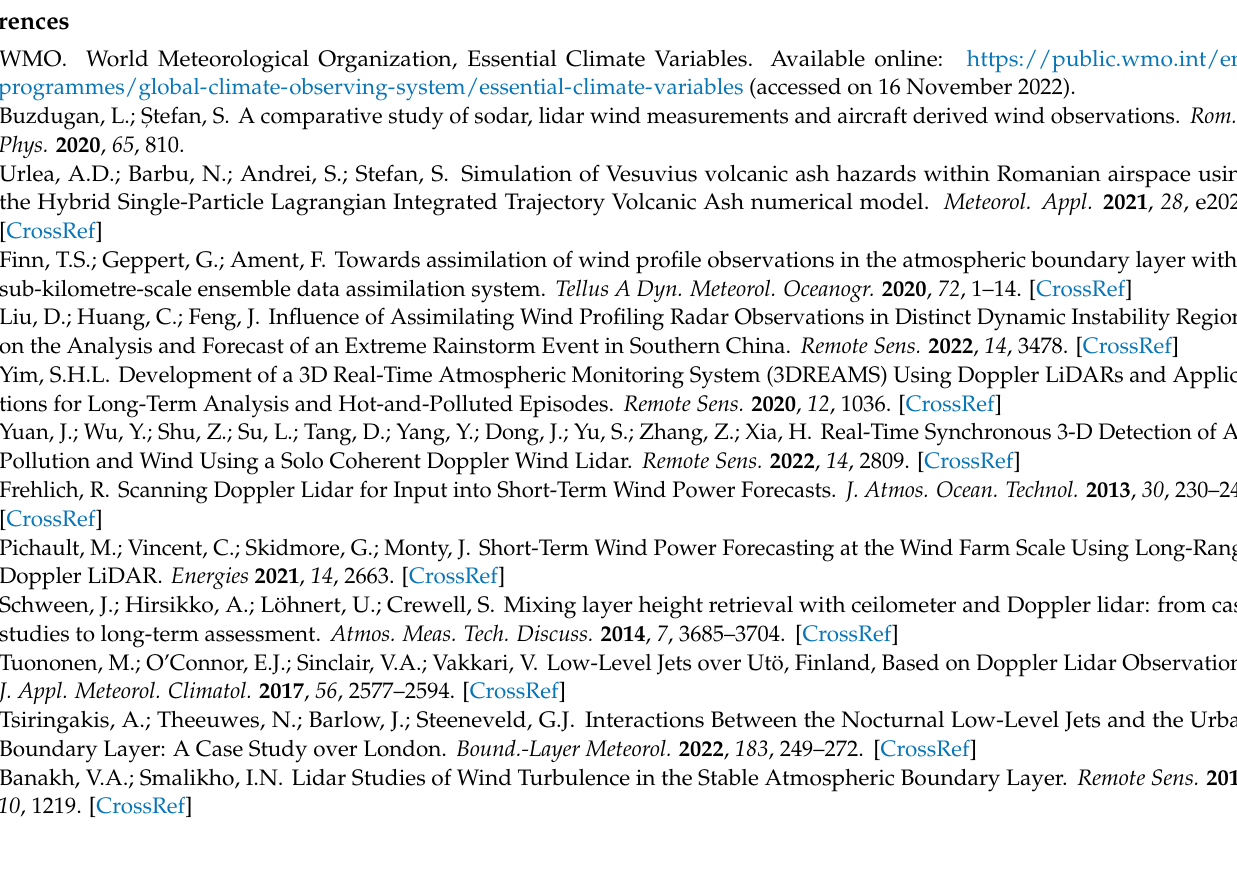
Figure A2. ERA5 hourly means of horizontal wind speeds for 1990–2020 climatology period for all seasons ( a – d ) and the mean speed profiles for daytime and nighttime ( e – h